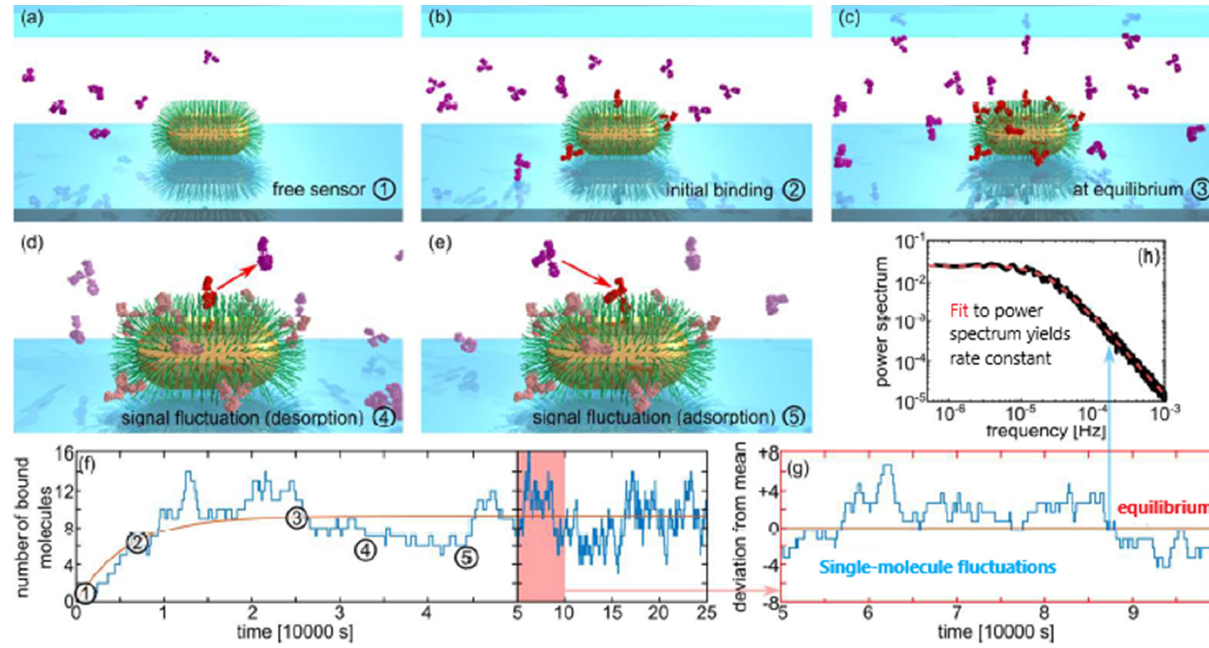
Figure 13. ( a – e ) Nanoplasmonic LSPR sensing of single-molecule equilibrium fluctuations. ( f ) Simulated response of a nanosensor to binding of analyte molecules (blue) and the corresponding average over many sensors (orange). ① A nanorod covered with a receptor layer is exposed to flow of analyte solution. ② Analyte molecules bind to the receptors and surface coverage eventually reaches equilibrium ③ , at which time averaged numbers of associating and dissociating molecules are equal. However, molecules continue to ④ dissociate and ⑤ associate at random times. This causes short time-scale fluctuations of the surface occupancy around the mean. ( g ) Once equilibrium is reached, molecules associate and dissociate stochastically with rates determined by k on , k off , and ρ , causing single-molecule fluctuations around the equilibrium signal. In this regime, the system ceases to be mass transport limited. ( h ) Analysis of power spectrum of equilibrium fluctuations yields accurate values of rate constants. Adapted with permission from A ć imovi ć et al. [64] Copyright © 2018 American Chemical Society.